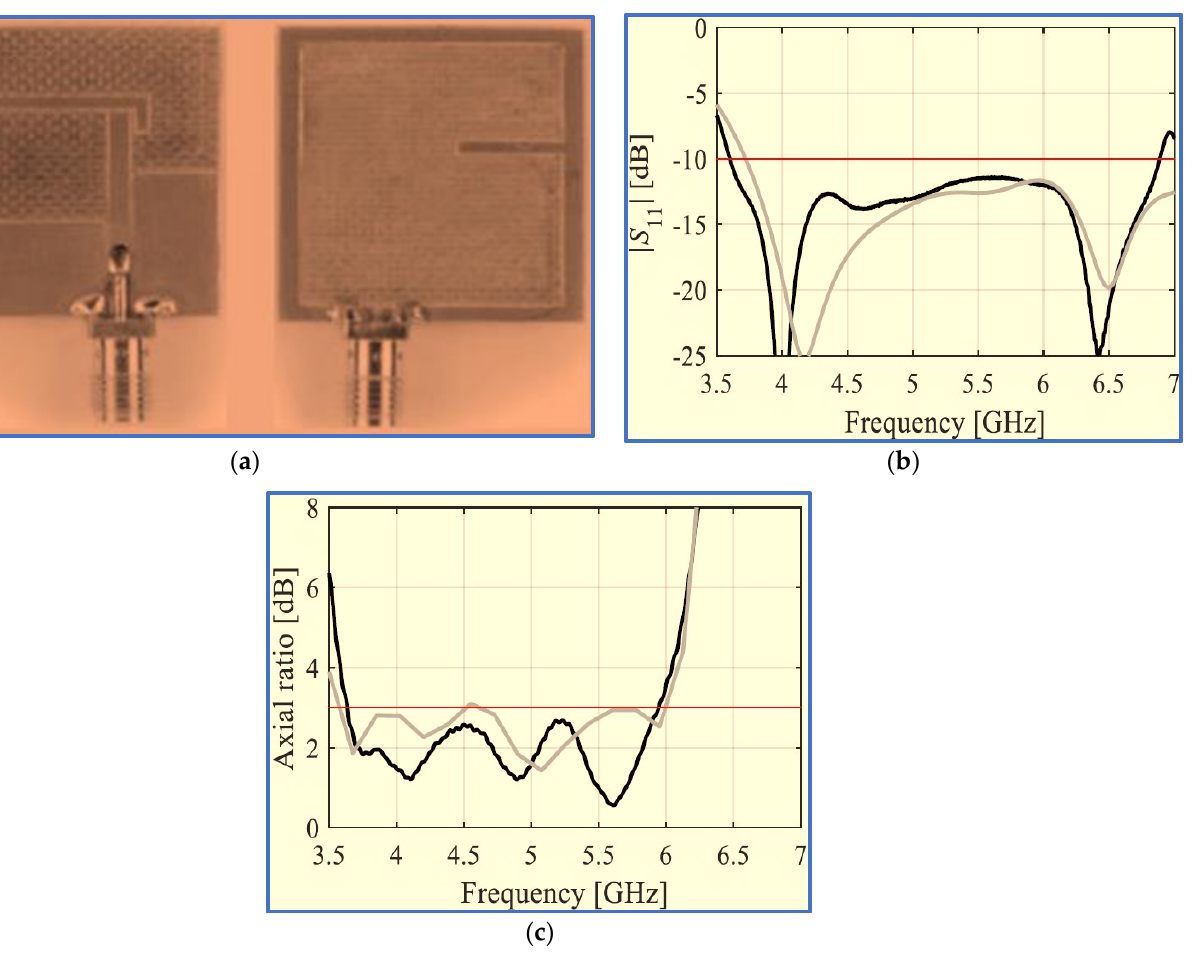
Figure 13. ( a ) Front and back views of a wide rectangular CP slot antenna. ( b ) Simulated (gray) and measured (black) S11 results. ( c ) Simulated (gray) and measured (black) AR results from [90].